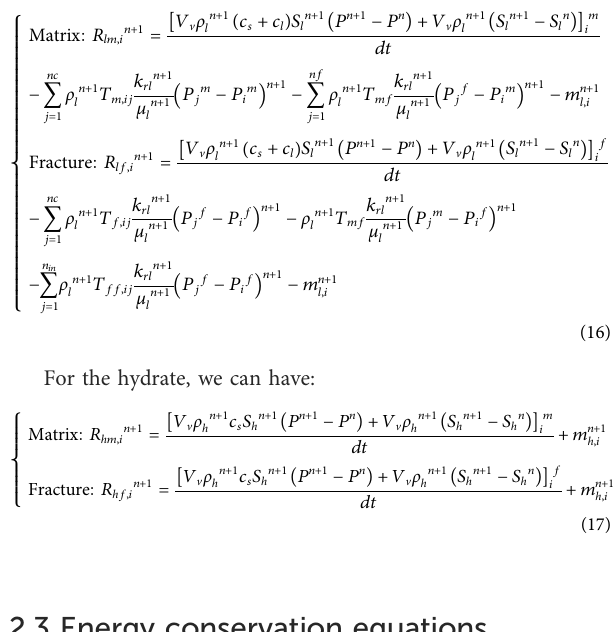
#3 NNC: the connections between intersected fractures segments.